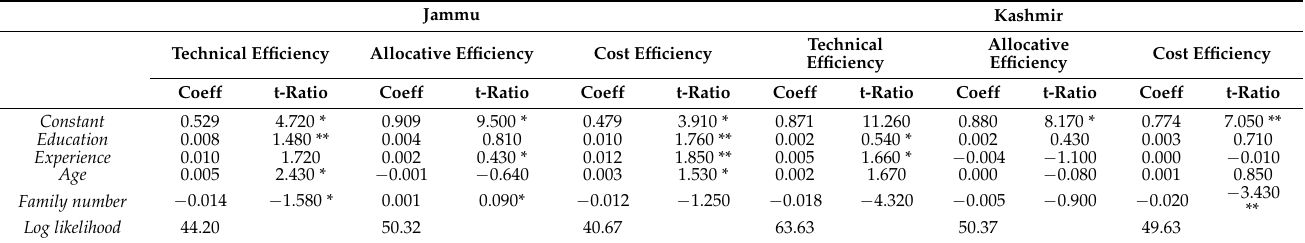
Table 7. Tobit estimates of the variables of efficiency function in Jammu and Kashmir. Jammu Kashmir Technical